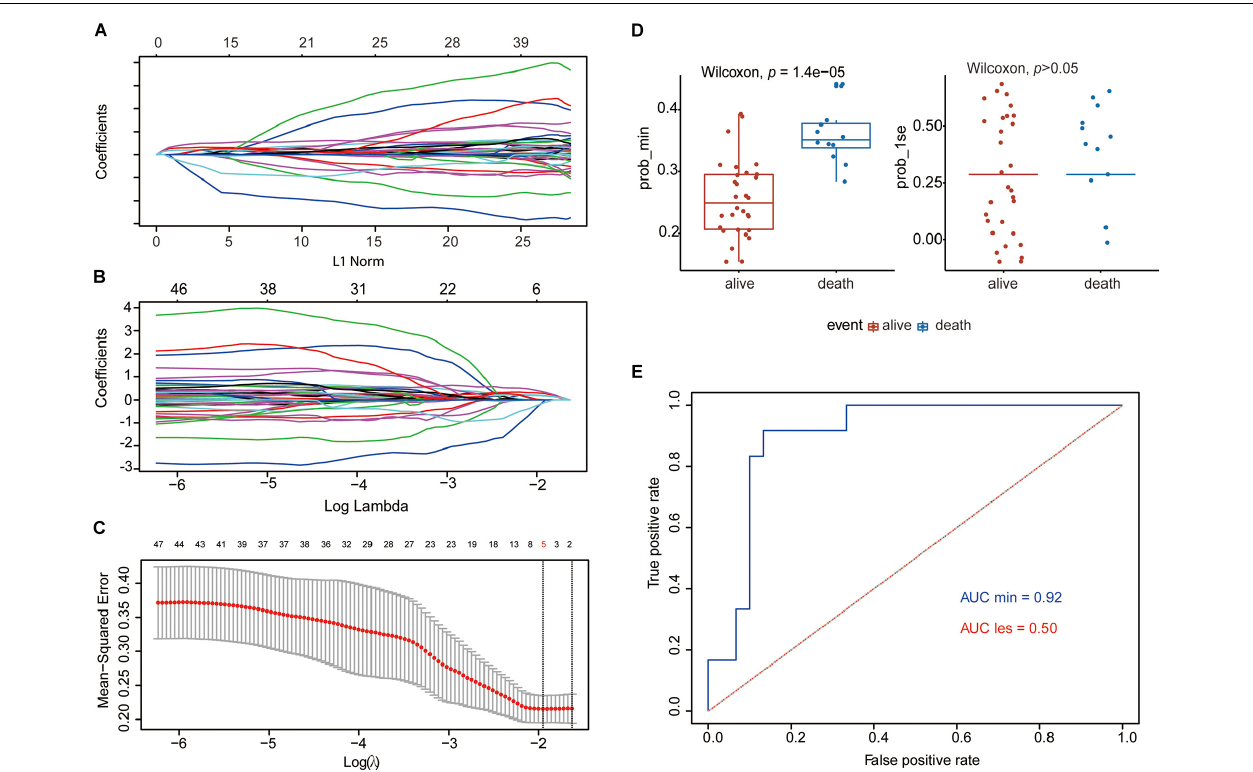
FIGURE 2 | Establishment of the five-gene prognostic model by Lasso regression analysis based on the 349 SE-associated genes from data downloaded from SEdb. (A , B) Lasso coefficient profiles of the 349 SE-associated genes. (C) Two optimal lambda ( λ ) values ( λ min and λ lse ) were estimated according to the vertical lines with a minimizing mean-square error. The vertical axis represents the mean-square error, while the horizontal axis represents the value of log( λ ). (D) The scatter plot of survival status of patients with osteosarcoma based on the five-gene model (left, λ min , p = 1.4e − 05) or two-gene model (right, λ lse , p > 0.05) using the Wilcoxon test. (E) ROC curves of the two prognostic models based on λ min and λ lse . The values of AUC were included in the figure. AUC, area under the curve; Lasso, least absolute shrinkage and selection operator; ROC, receiver operating characteristic; SE, super-enhancer; SEdb, super-enhancer